Question: According to the figure, is the described quantity increasing or decreasing?
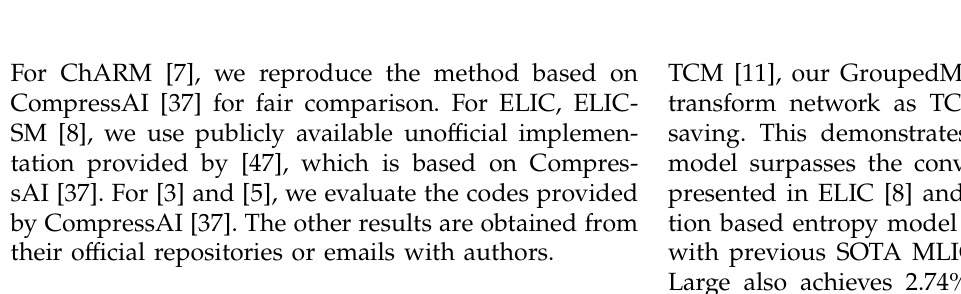
Answer: increasing